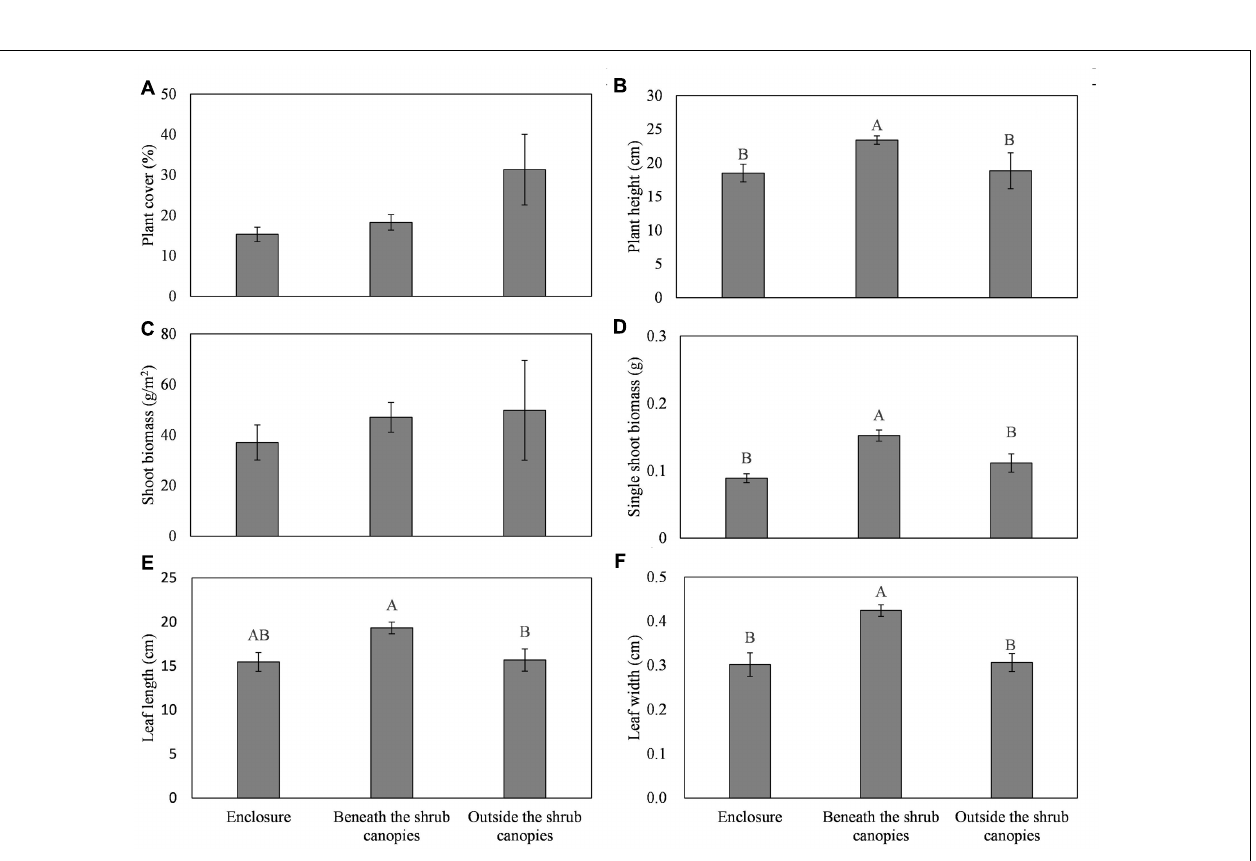
Frontiers in Plant Science |